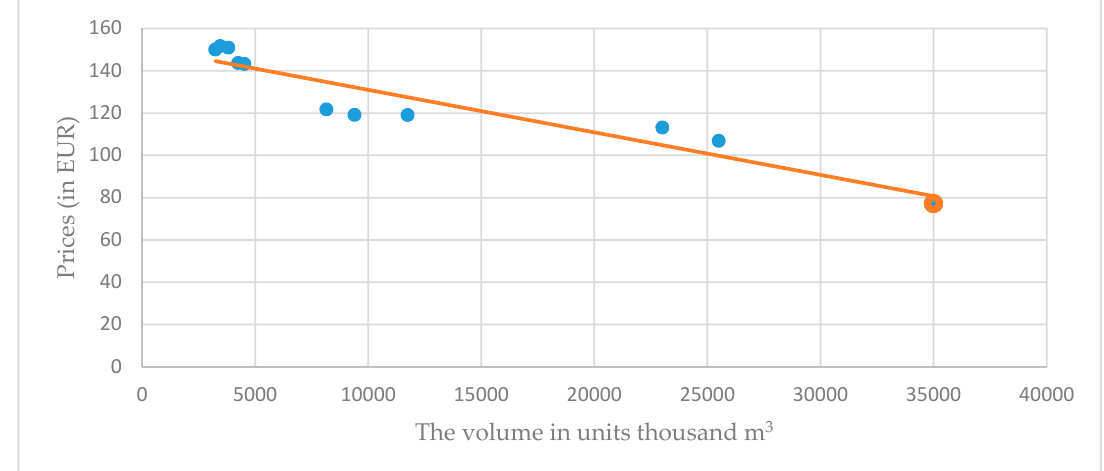
Figure 5. The estimation of the price of spruce wood depending on the volume of incidental logging; Source: Own calculations; Result of regression model: y = − 0.002x + 151.09; R 2 = 0.875.